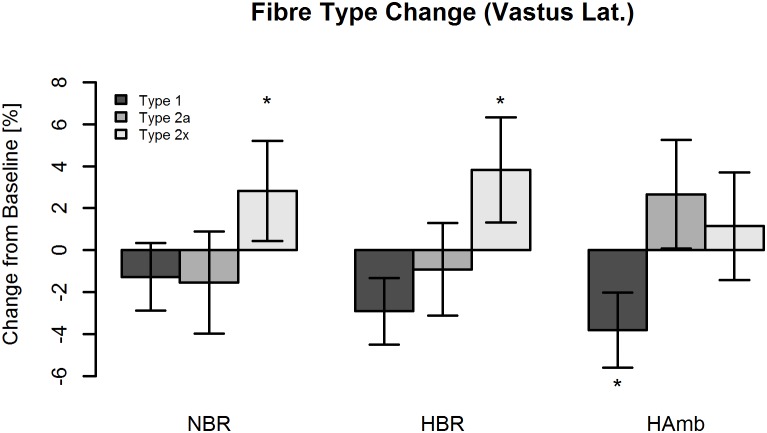
Type 1, type 2a, and type 2× fiber changes within the vastus lateralis muscle following normoxic bed rest (NBR), hypoxic bed rest (HBR), and hypoxic ambulation (HAmb) interventions. Data are presented as means ± SE. ∗(p < 0.05) denotes significant difference compared to baseline.